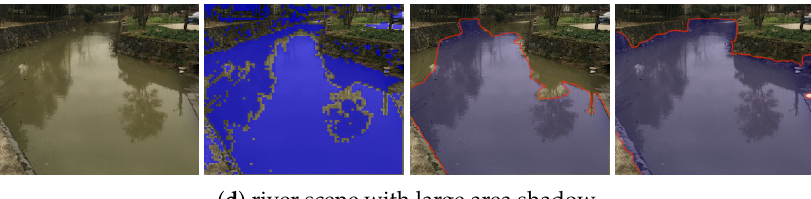
Figure 12. Segmentation results of different algorithms in complex scenes ( a – d ). From left to right: The first column are the input images after pre-processing; The second and third column are respectively the segmentation results using “intensity + texture” features and the adaptive threshold edge detection algorithm; The fourth column are the results of our method.